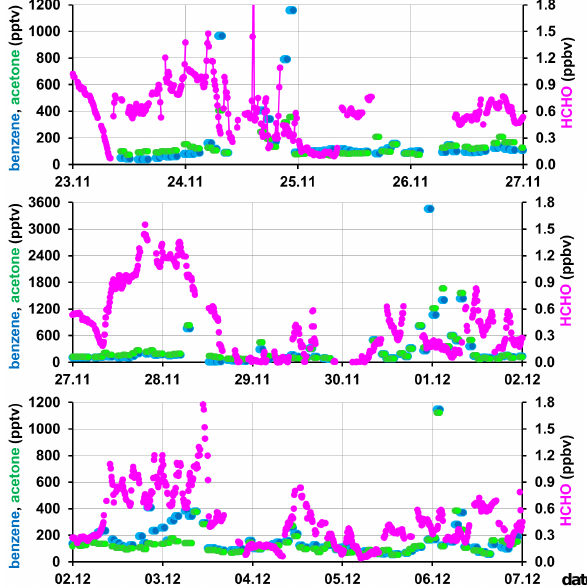
Fig. 3. Time series of selected trace gases measured during DOMINO. The scale of the y-axis is intendedly kept different for